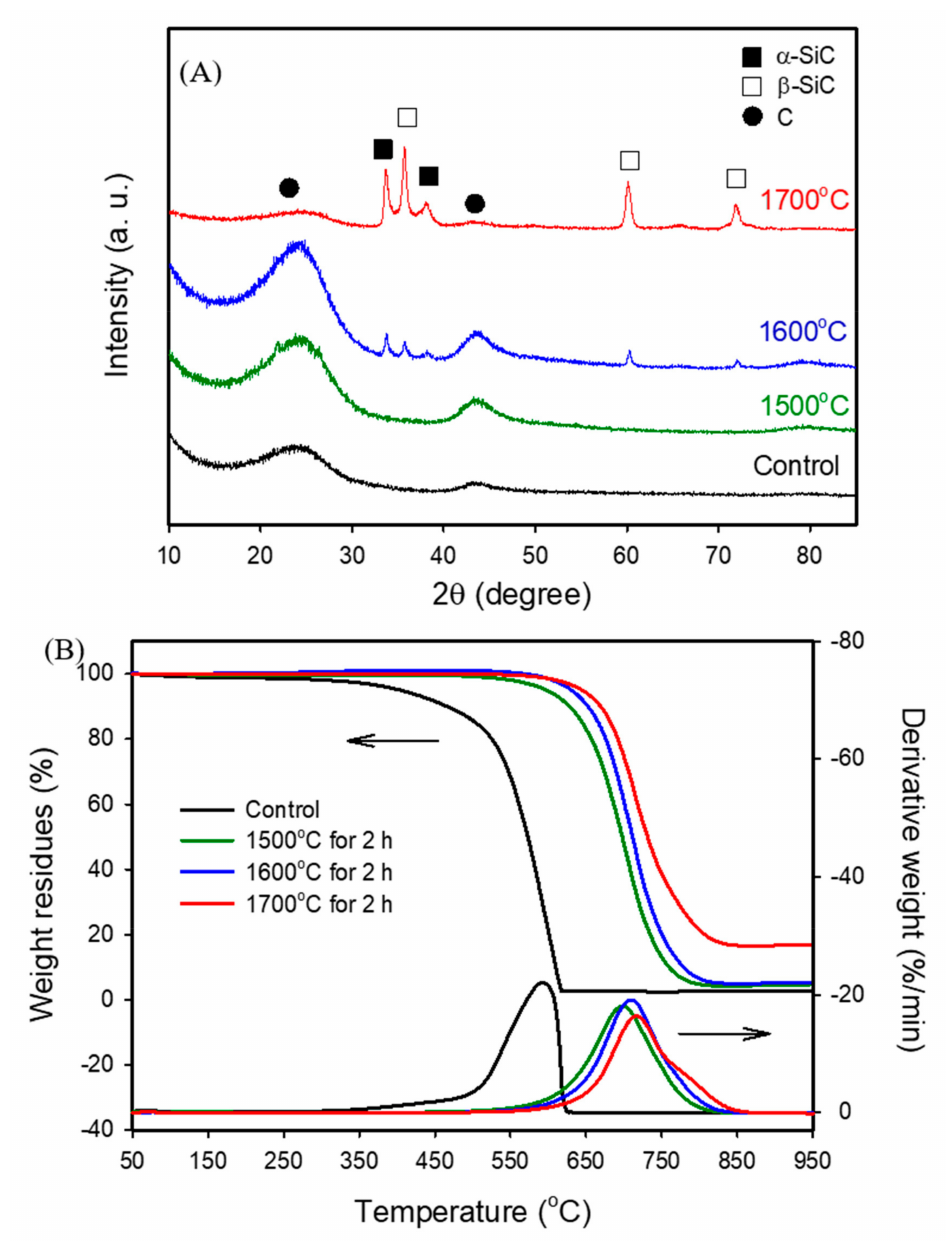
Figure 2. X-ray di ff raction (XRD) patterns ( A ) and thermogravimetric analysis (TGA) / derivative thermogravimetry (DTG) curves ( B ) of BcSiCs sintered at di ff erent temperatures for 2